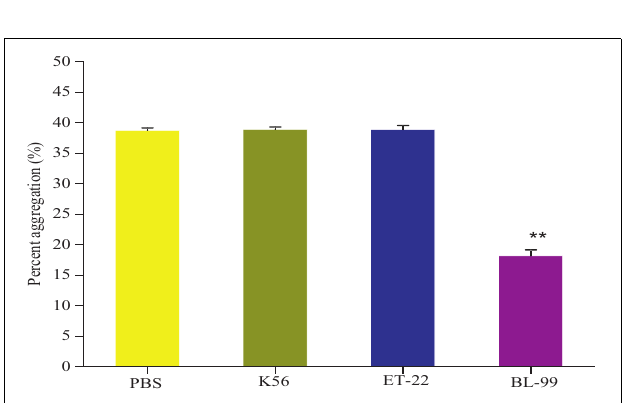
FIGURE 2 | SDS-PAGE analysis of mucin degradation by three tested strains. Lanes 1–5 were negative controls (uncultured mucin fluid), BL-99, marker, ET-22, and K56, respectively.